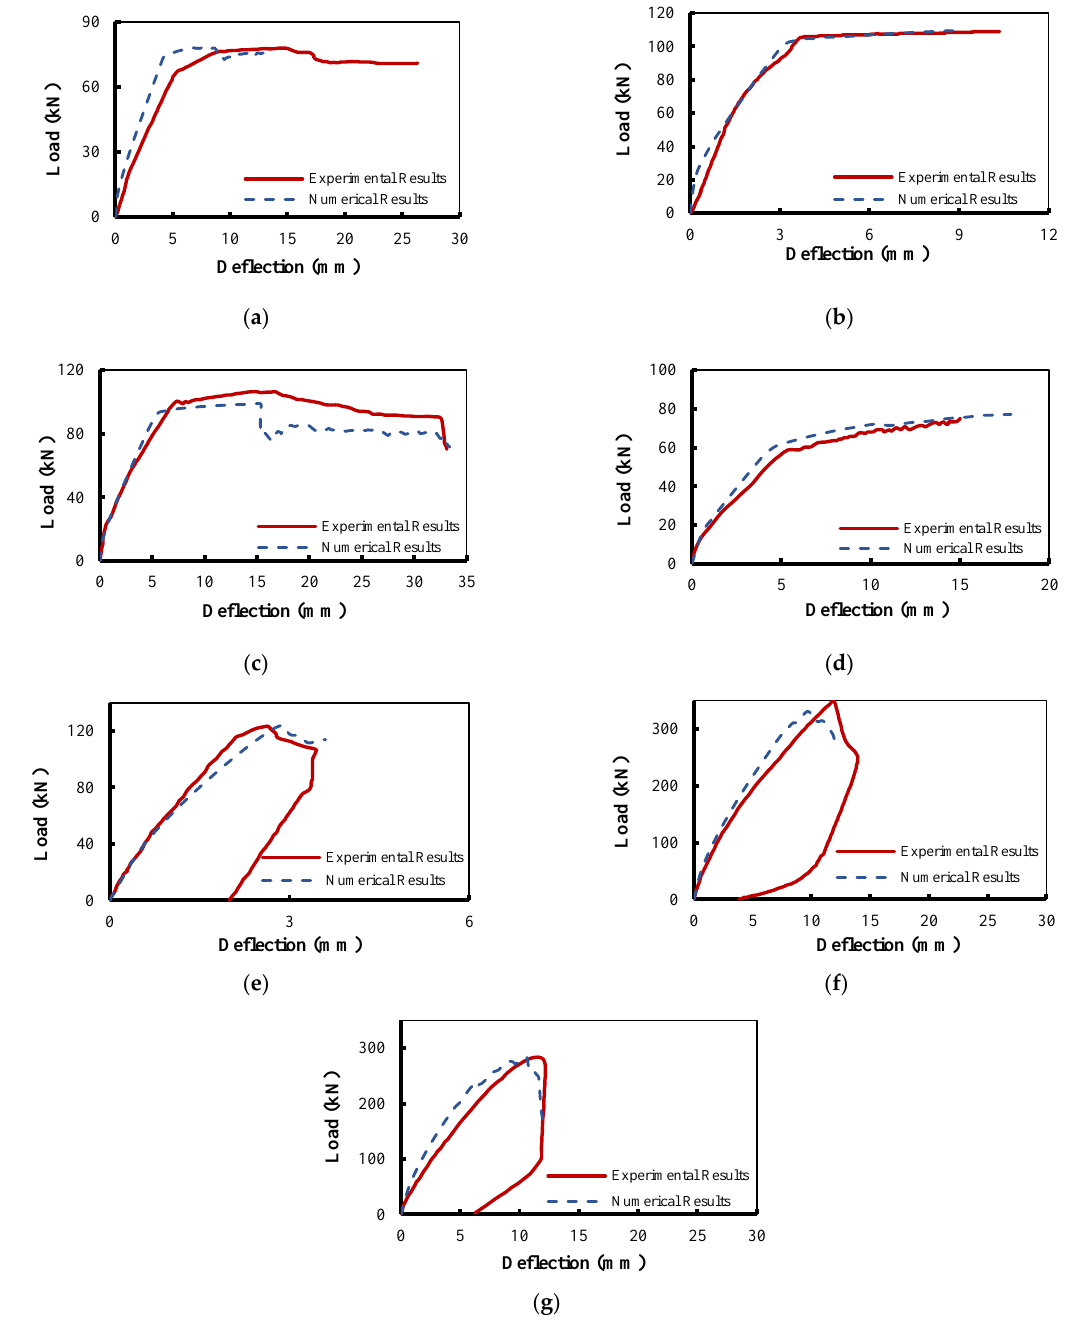
Figure 18. Load–Deflection Response: ( a ) Specimen (CBA); ( b ) Specimen (C); ( c ) Specimen (N-1); ( d ) Specimen (FB30-1); ( e ) Specimen (CON-S0); ( f ) Specimen (CON-S1); ( g ) Specimen (CON-S3).